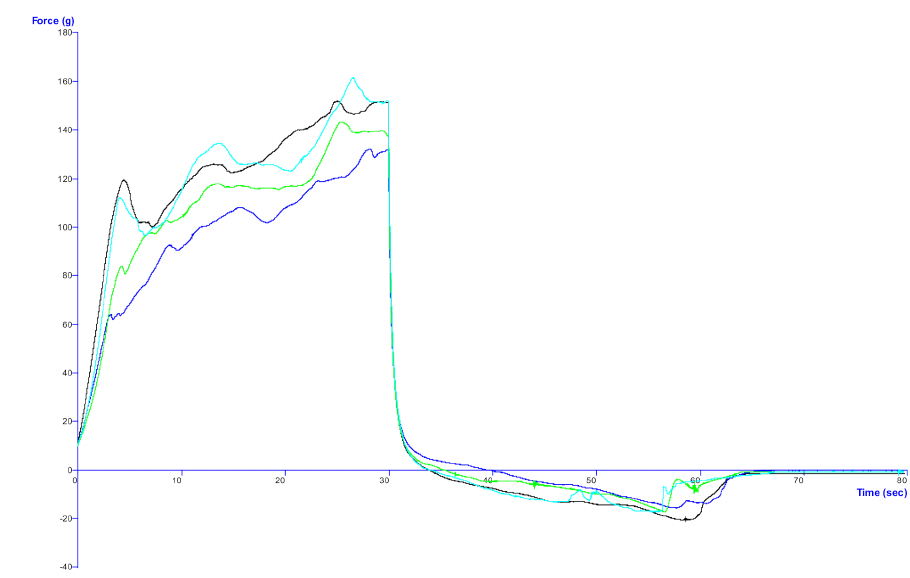
Figure 2. Analysis of the texture profile of kefir samples on the tenth day of